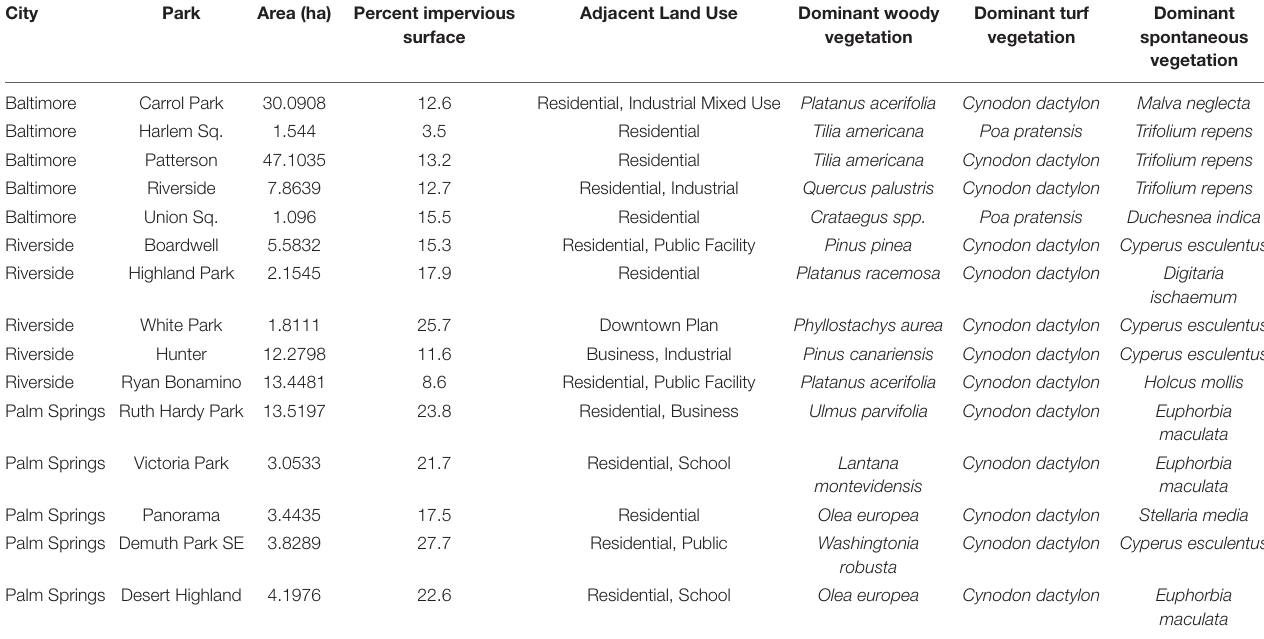
TABLE 1 | Descriptions of urban form and dominant vegetation in each